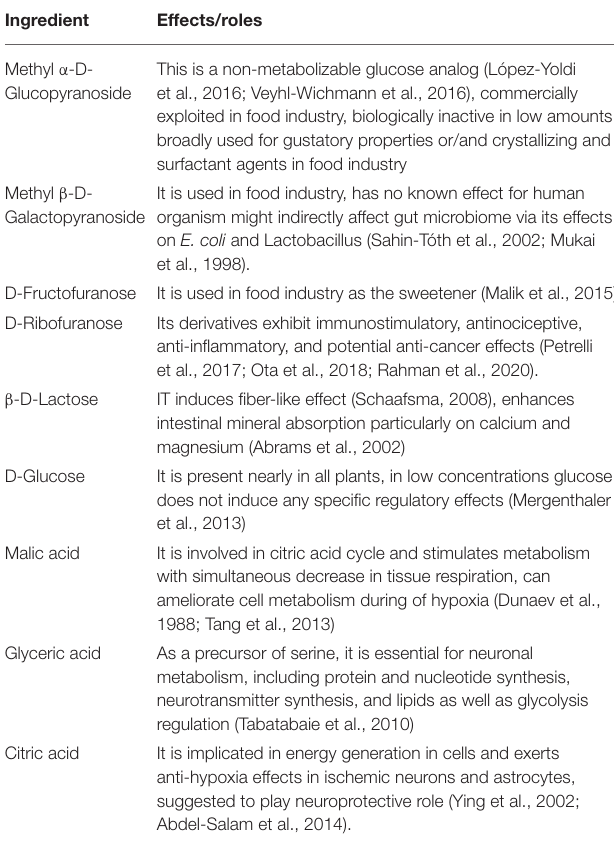
TABLE 3 | Functions of SHC chemical ingredients (for References, see Supplementary Material ).